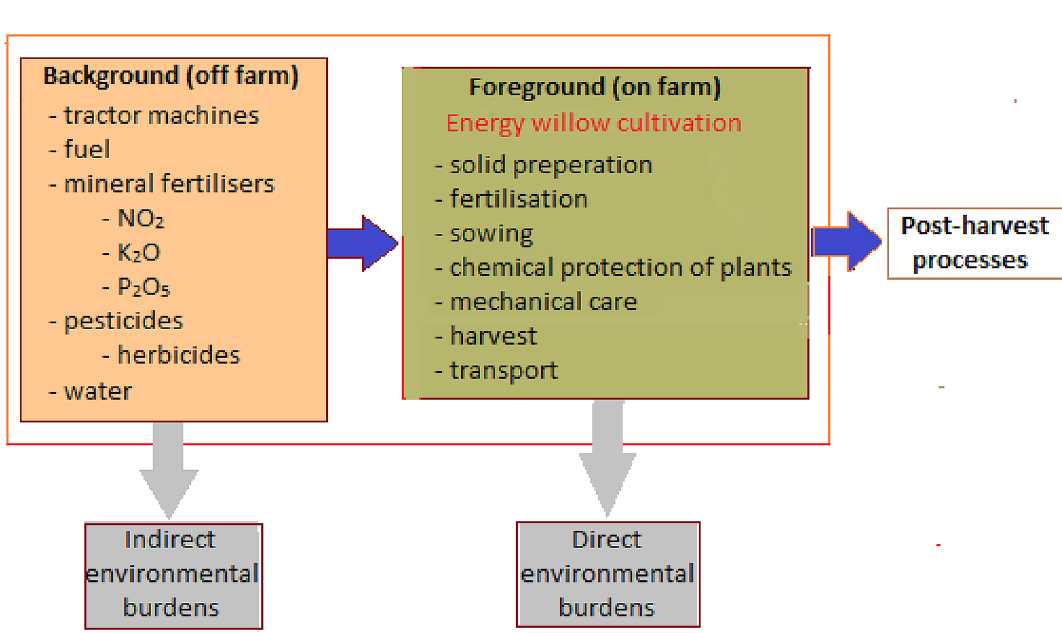
Figure 2. System